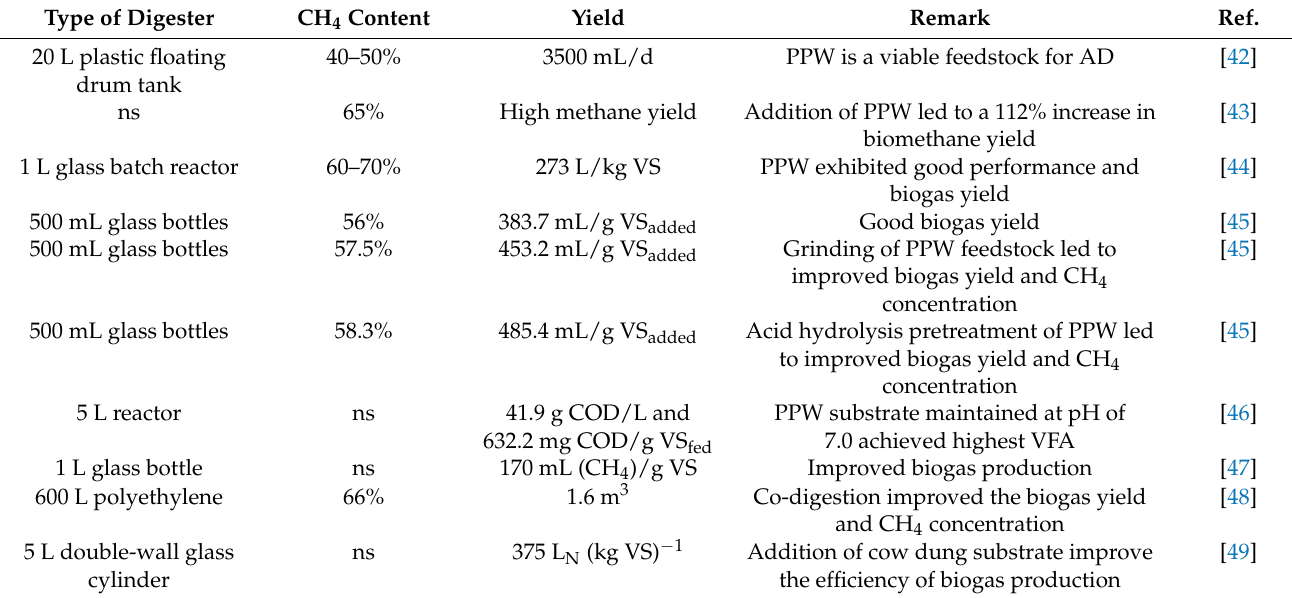
Table 2. Some of the reported productions of biogas from